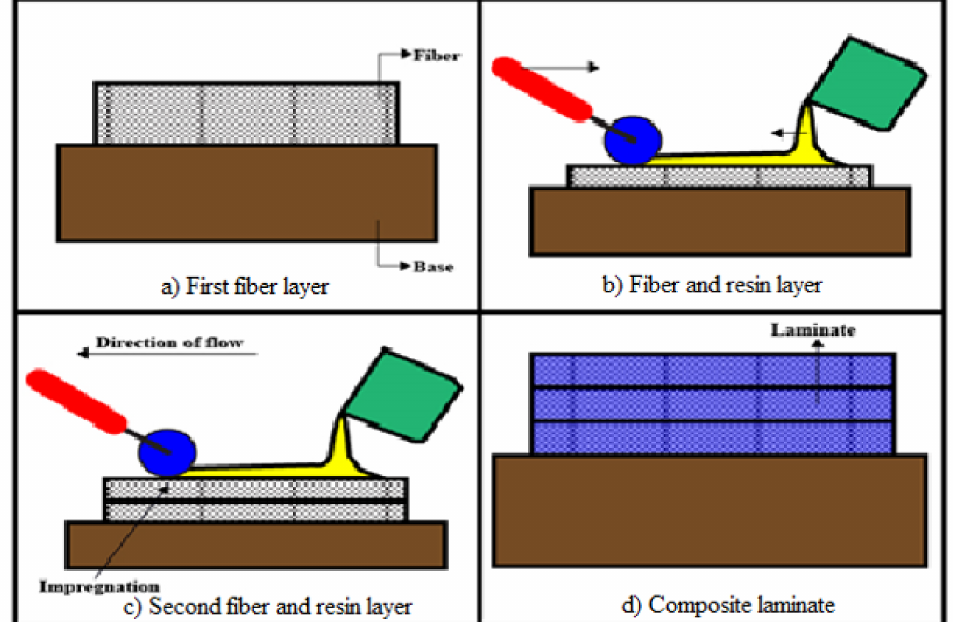
Figure 3. The schematic fabrication process of the hybrid composite.